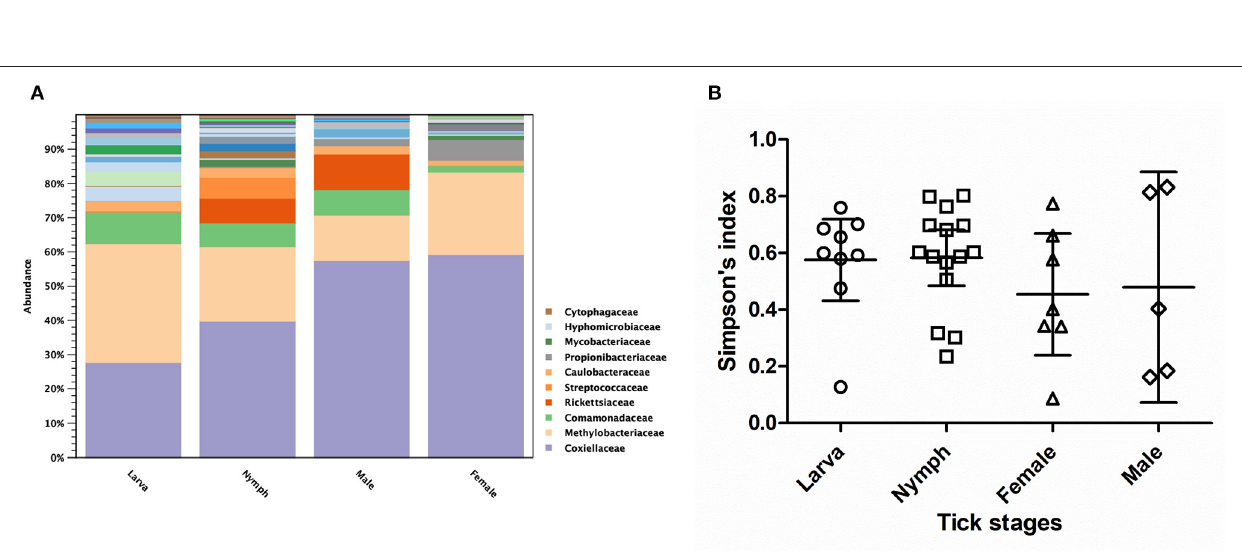
FIGURE 5 | Taxonomic diversity and relative abundance at the family level of bacterial community (A) and scatter plots of alpha diversity measure (Simpson’s index) (B) in three developmental stages of Haemaphysalis spp. ticks. The solid lines show mean and 95% Confidence Interval of alpha diversity for each group. Color legend for each family was indicated next to the bar